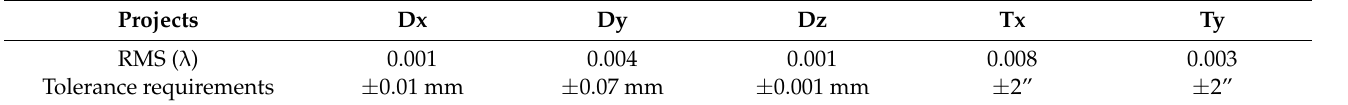
Table 2. M2 wave aberration and mounting tolerance requirements.